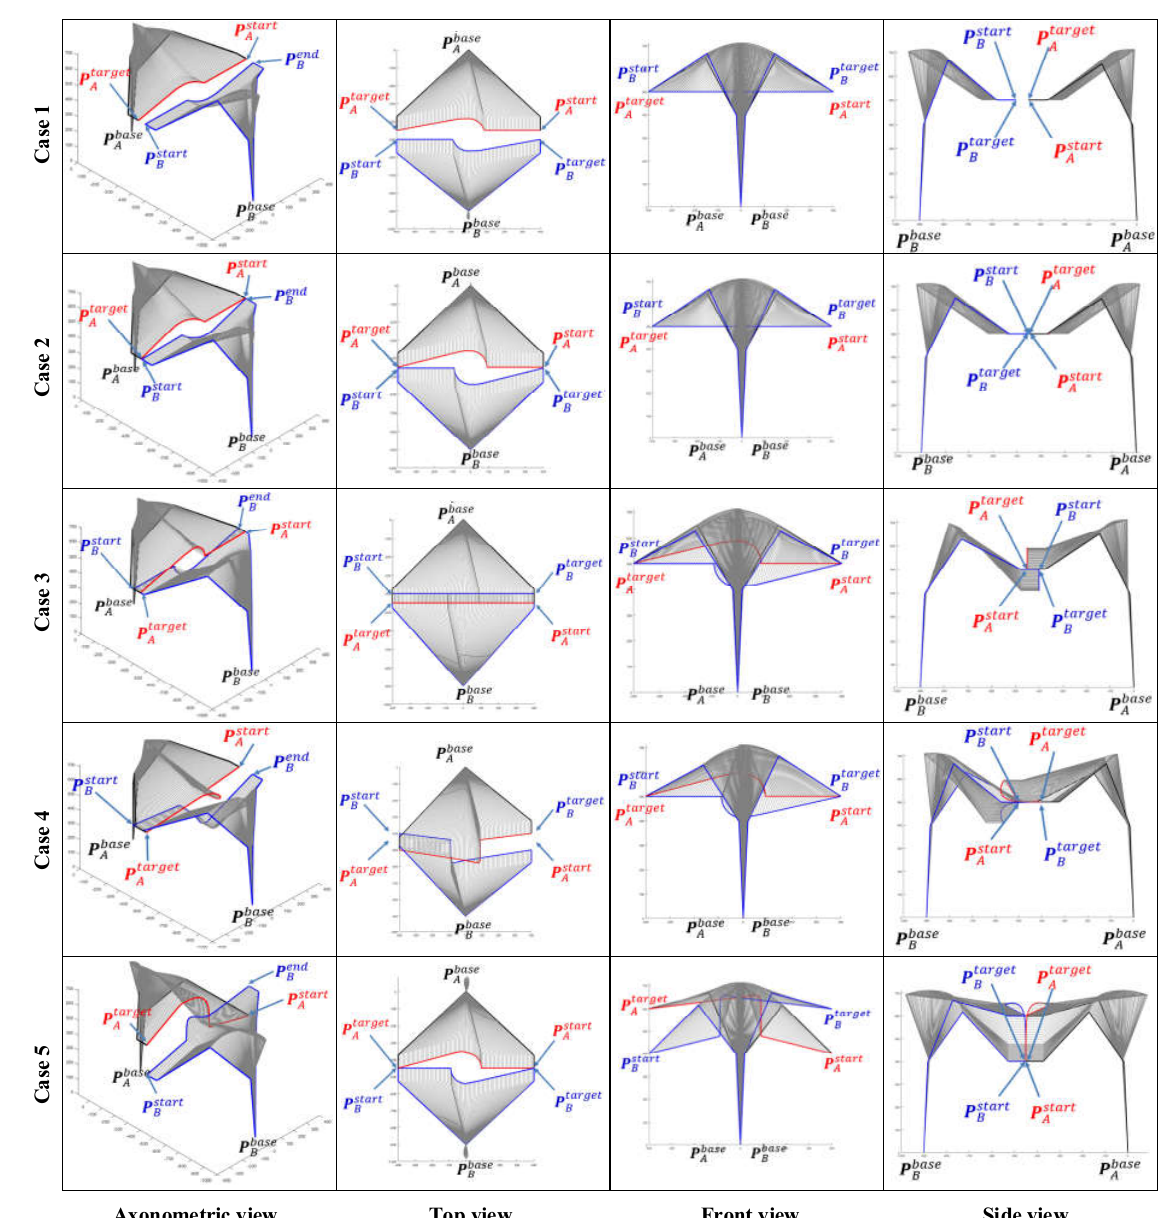
Figure 13. Comparison of dual manipulators avoidance simulation results for five initial path cases.